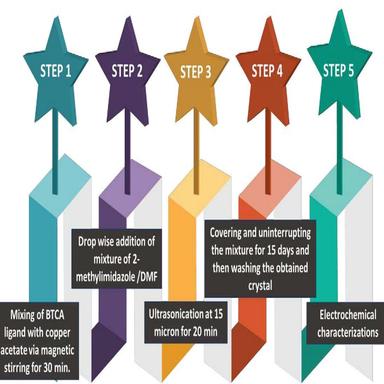
Scheme describing the synthesis steps of Cu-B-MI-MOF.